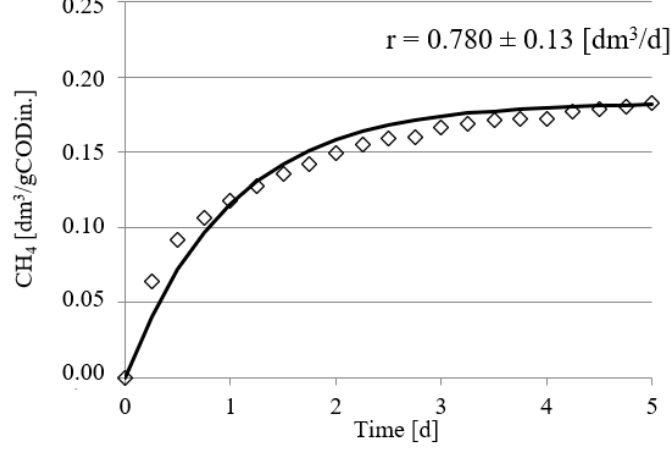
Figure 3. Course of methane fermentation in series 2.